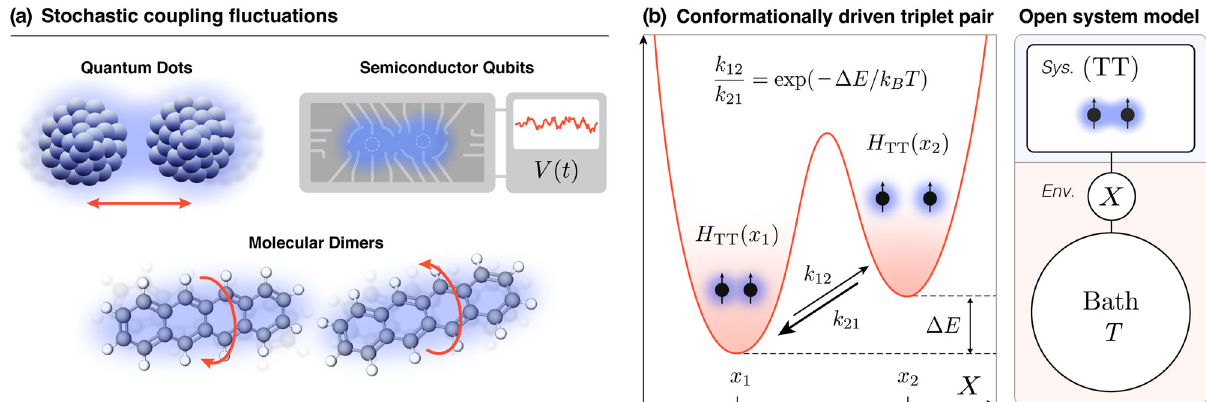
Fig. 1 Outline of the noisy-exchange model. a Exchange coupling fl uctuations that arise from various sources of noise are ubiquitous. They often negatively affect the performance of quantum information processing of quantum dots and superconducting qubits 4 . In molecular dimers, exchange coupling fl uctuations can instead be bene fi cial, as we show in this work, for the formation of high-spin states. b We consider a system given by a triplet pair (TT), consisting of two spin-1 particles, that undergoes spin mixing due to fl uctuations in the spin Hamiltonian H TT ( x t ) driven by a conformational coordinate X . The latter interacts with a large bath of nuclear vibrations at thermal equilibrium with temperature T . In the Results, we focus on the case of exchange fl uctuations J ( x fi ciency of quintet formation depends on the stochastic process f X ð t Þ : t 2 R t ) and discuss how the ef þ g7!f J ð x t Þg , whose two-time correlation functions respect the thermodynamic detailed balance condition. For example, if the conformational coordinate has only two states, all dynamics are described by the forward and reverse transition rates k 12 , k 21 whose ratio is determined by the difference in energy Δ E of the conformations, Boltzmann ’ s constant k B , and the system temperature T